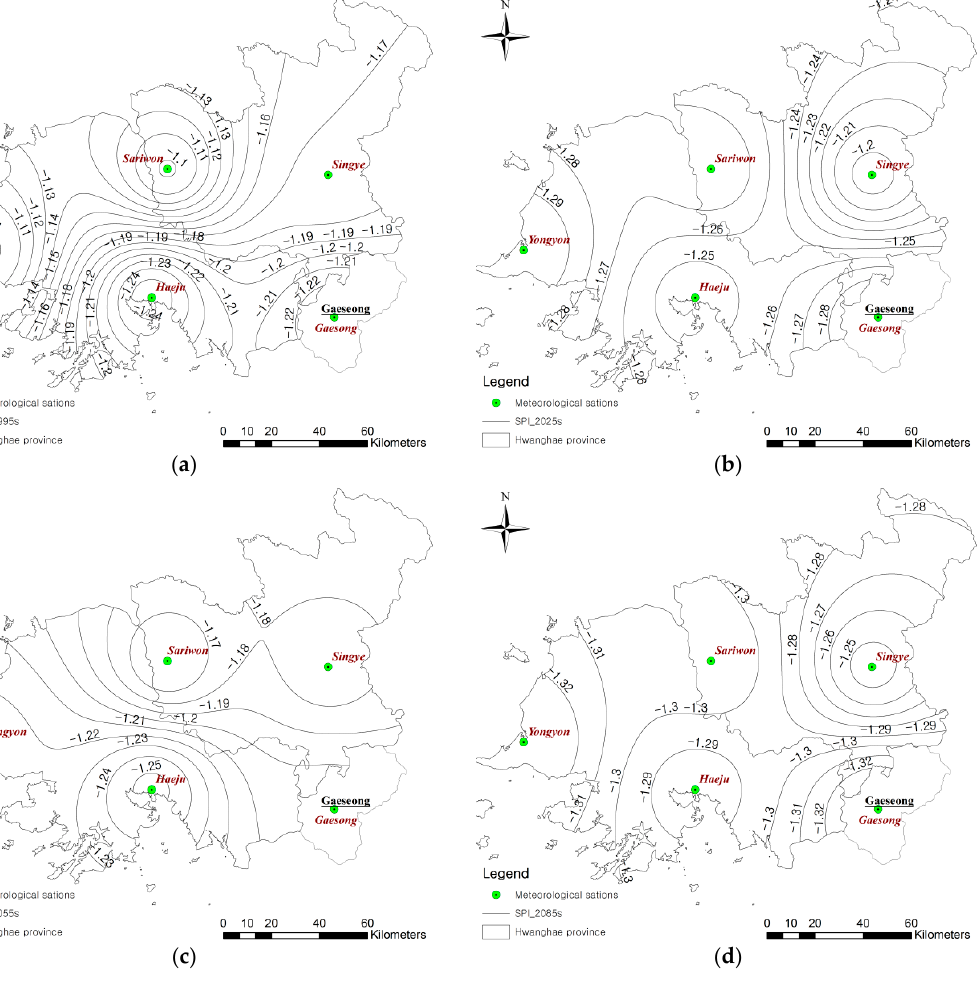
Figure 9. Contour lines of the one-month SPI for a ten-year return period: ( a ) 1995 (1981–2010); ( b )